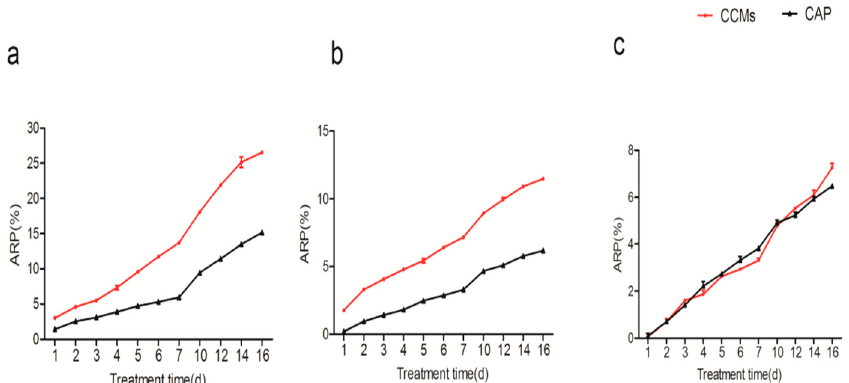
Figure 1. The sustained release properties of the CCMs synthesized in varied solutions: ( a ) NaOH solution (pH 9.94), ( b ) HAc solution (pH 3.03), and ( c ) NaCl solution (pH 7). Data were expressed as mean ± SD ( n = 3); CAP, capsaicin; CCMs, capsaicin/chitosan microcapsules.